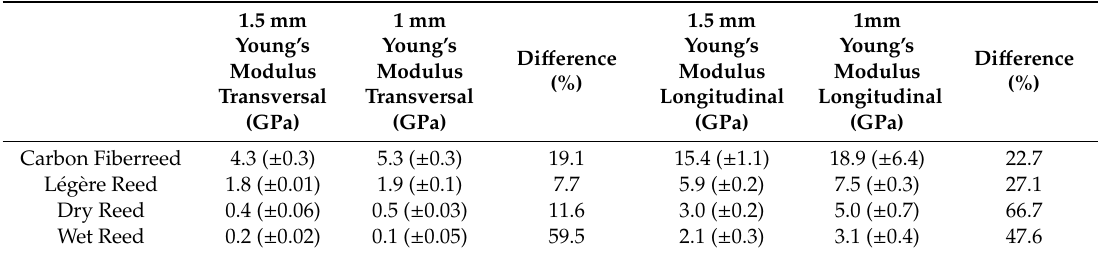
Table 4. Moduli of elasticity for reed specimens with di ff erent